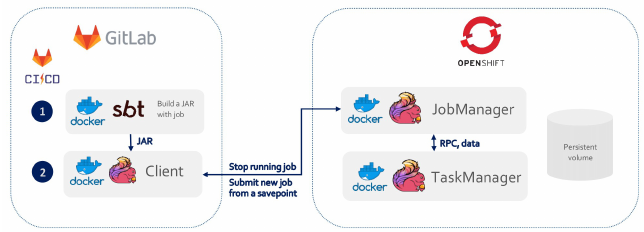
Figure 5. Deployment of new Flink